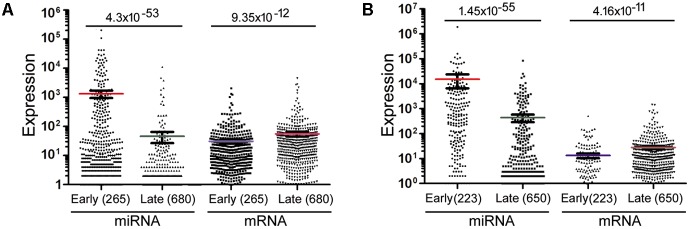
Mann–Whitney U test to compare miRNA and mRNA expression in representative samples. (A) miRNAs and mRNAs in the GM12878 10 kb data were separated into two groups (“early” and “late”) based on a miRNA cut-off at 600. Spots represent individual RNAs, means and standard errors of means shown as bars, and sample sizes in parentheses. The p-values of Mann–Whitney U test are shown on top. (B) miRNAs and mRNAs in the mouse bladder 2 kb dataset were separated into two groups (“early” and “late”) based on a miRNA cut-off at 400. Labelings are the same as in (A).